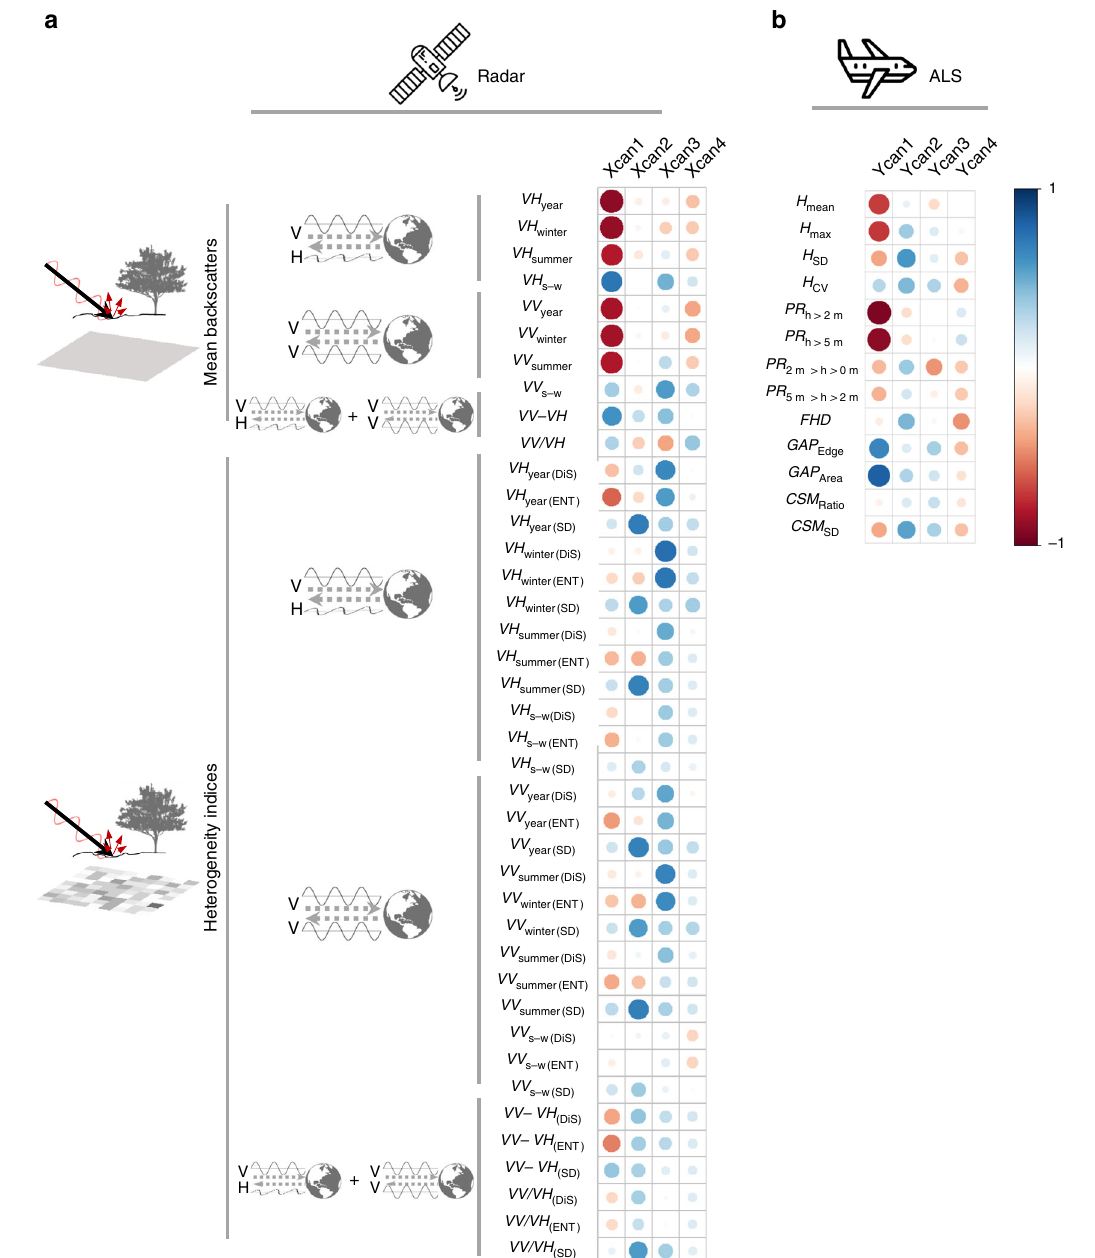
Fig. 2 Ecological relevance of the metrics from the two sensors. Pearson ’ s correlation matrix a between the fi rst four main canonical axes (Xcan1 – 4) and the radar metrics and ( b between the fi rst four main canonical axes (Ycan1 – 4) and the ALS metrics at the signi fi cance level p < 0.05. The fi rst canonical axes represent a gradient of decreasing forest maturity, and the second, third, and fourth canonical axes gradients of structural heterogeneity. Positive correlations are displayed in blue and negative correlations in red colour. Colour intensity and the size of the circle are proportional to the correlation coef fi cients. See Supplementary Tables 4 and 5 for